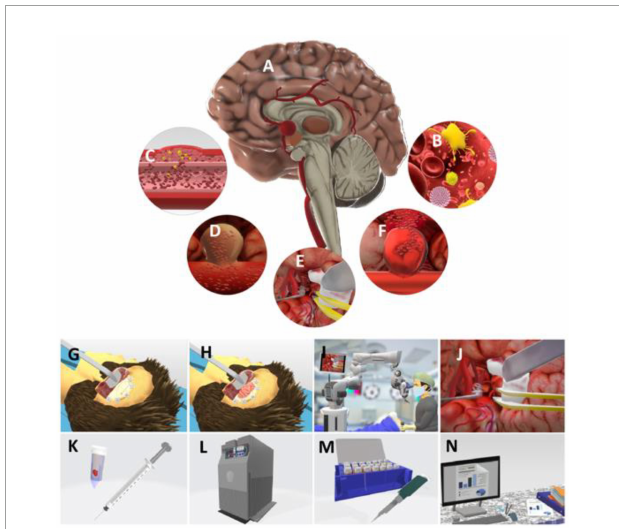
FIGURE2 Schematic sequence of the study method. Panel (A) represents the intracranial aneurysm; (B) pathogenic oral virus that promote inflammatory changes in the microbiota in specific host; (C) virus can move to the blood flow and deposit in cerebral vessels, inducing inflammatory response and changes in vessel wall, which added to risk factors already known can induce the formation of an